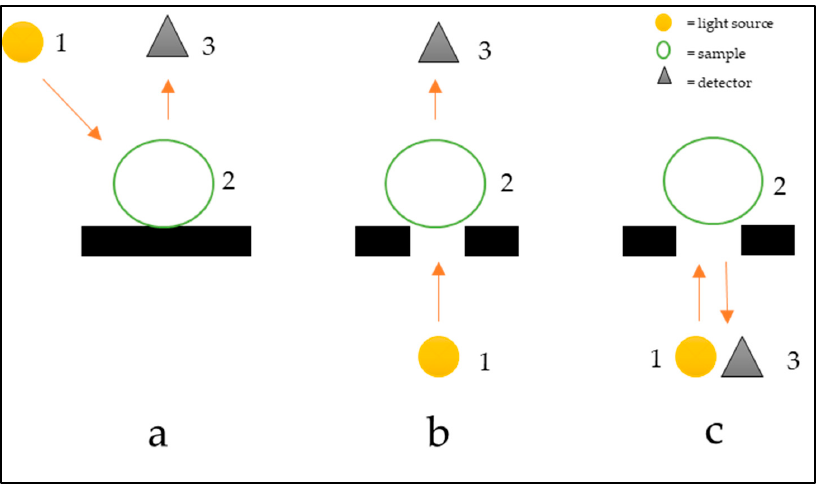
Figure 7. Setup for acquisition in reflectance ( a ), transmittance ( b ), and interactance ( c ). The arrows indicate the direction of light coming out of the lamp (1) hits the sample (2) and then reaches the detector (3).